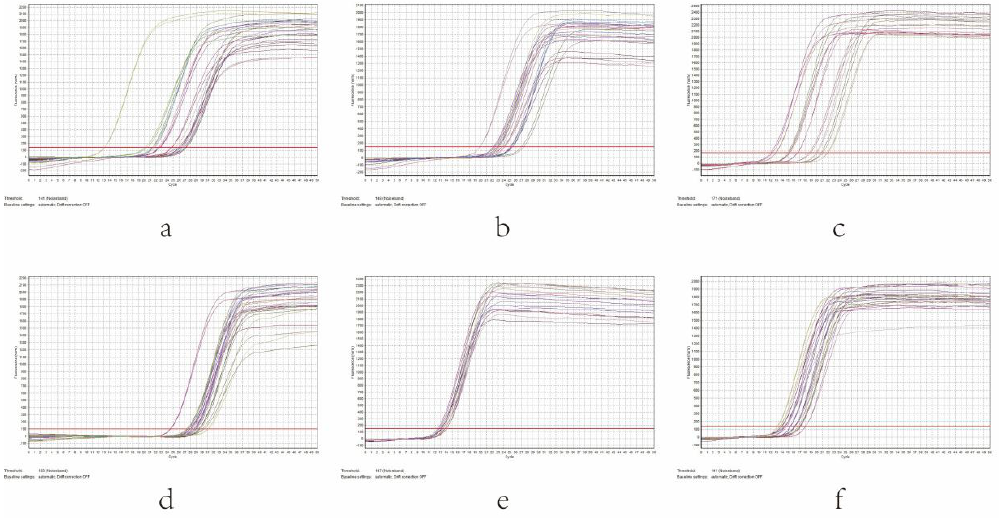
Figure 5. Amplification curve of intestinal microbiota in different groups of rats by real-time q-PCR. ( a ) Escherichia coil , ( b ) Enterococcus , ( c ) Lactobacillus , ( d ) Bifidobacterium , ( e ) Bacteroides fragilis , ( f ) Clostridium tender .